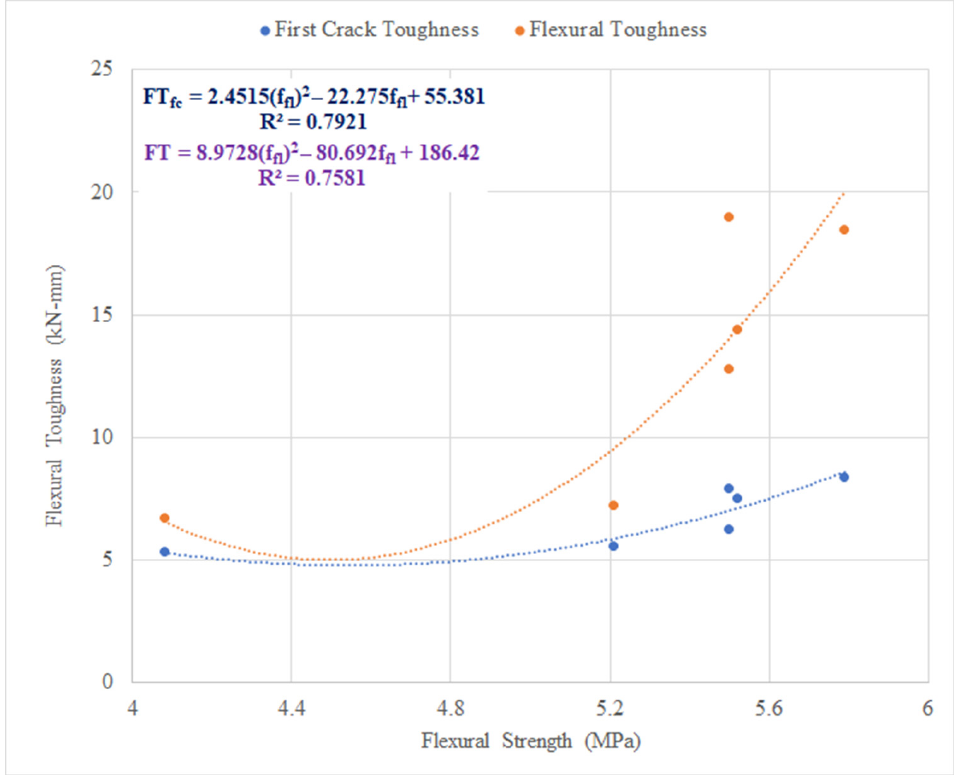
Figure 9. Correlation between flexural strength, f fl , and the flexural toughness at first crack, FT fc , and ultimate conditions, FT .